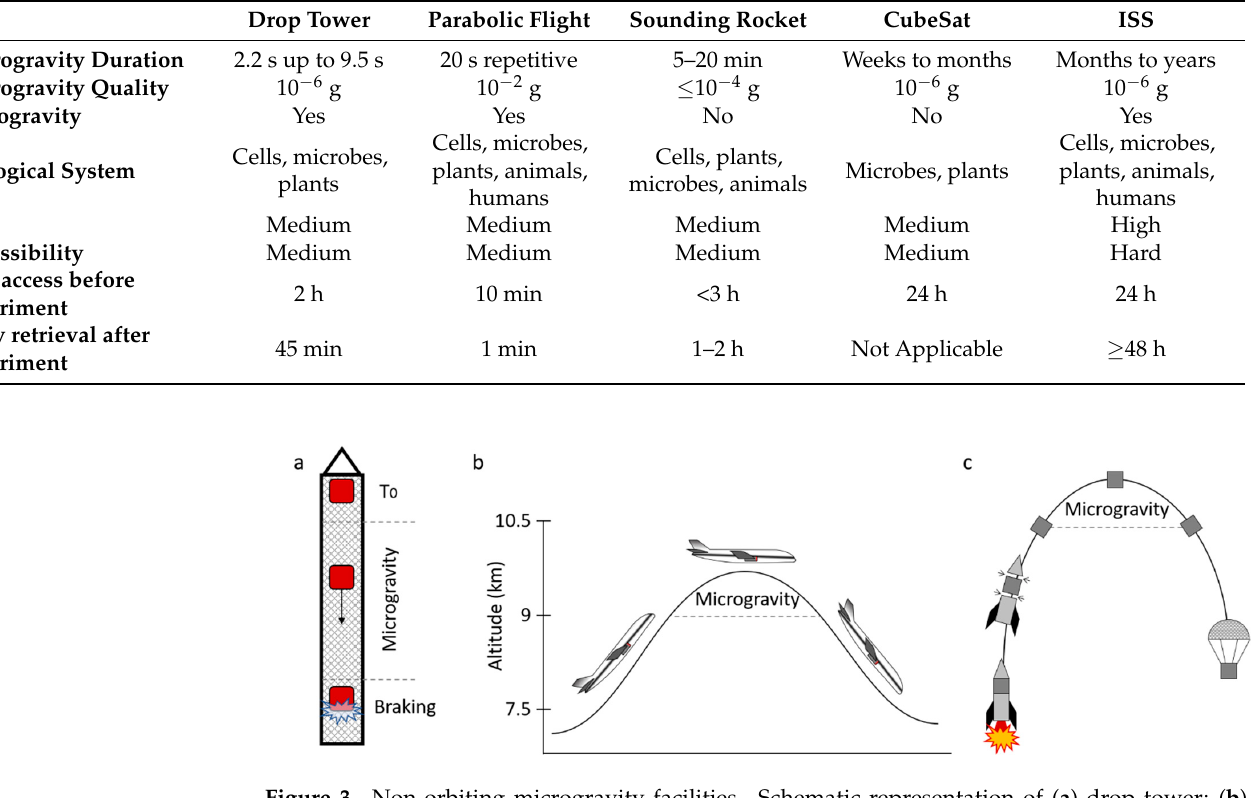
Table 3. Specifications of non-orbiting and orbiting microgravity facilities. ISS, International Space Station.